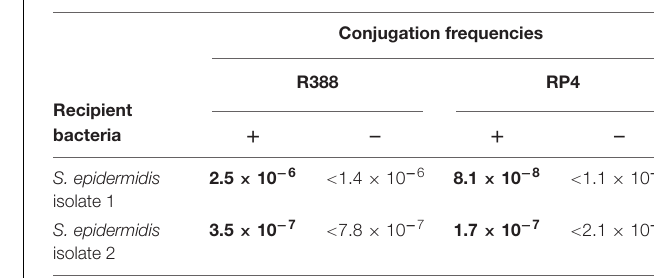
TABLE 7 | Conjugation frequencies from E. coli to S. epidermidis using conjugative systems R388 and RP4 a